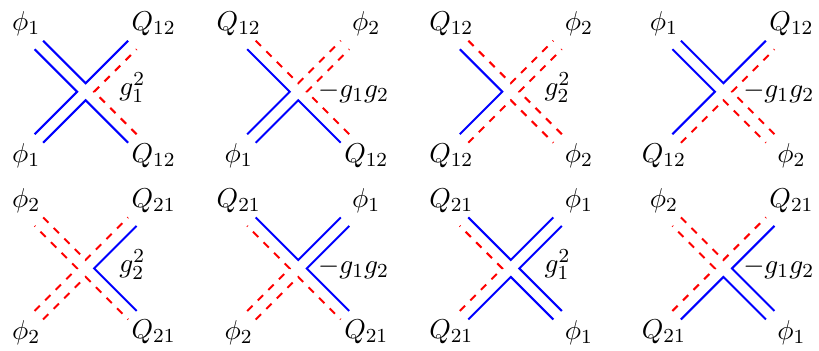
Figure 3 . The vertices contributing to the Hamiltonian in the XZ sector. A solid blue line denotes the first and a dashed red line denotes the second gauge group. Time moves upwards. Here we have already performed the Wick contractions of the conjugate fields with the second gauge invariant operator to write the vertices directly as spin chain